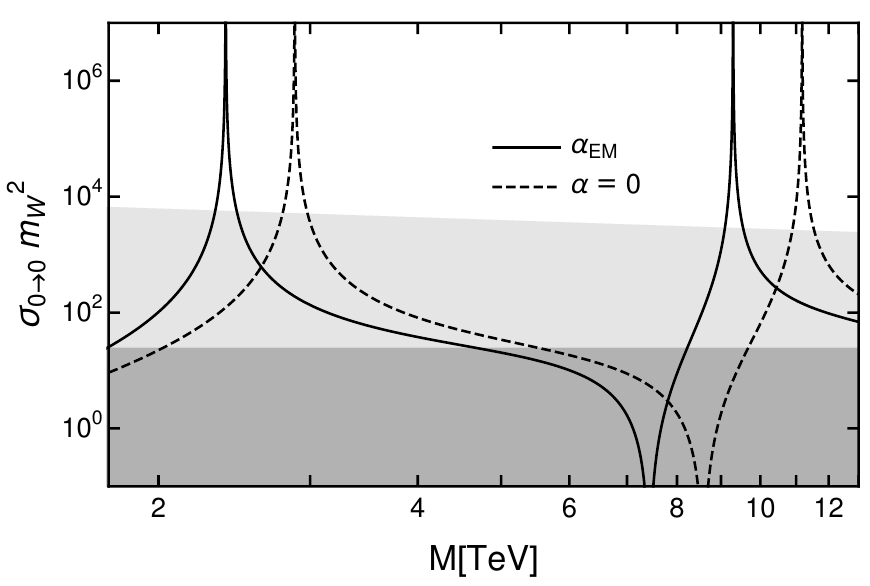
Figure 2 . The neutral-wino elastic cross section (cid:27) 0 ! 0 at zero energy as a function of the wino mass M . The cross section is shown for (cid:11) = 1 = 137 (solid curve) and for (cid:11) = 0 (dashed curve). If (cid:27) 0 ! 0 is above the darker shaded region ( (cid:27) 0 ! 0 < 8 (cid:25)=m 2 ), a zero-range e(cid:11)ective (cid:12)eld theory for winos is W applicable. If (cid:27) 0 ! 0 is above the lighter shaded region ( (cid:27) 0 ! 0 < 4 (cid:25)=M(cid:14) ), a zero-range e(cid:11)ective (cid:12)eld theory for neutral winos only is